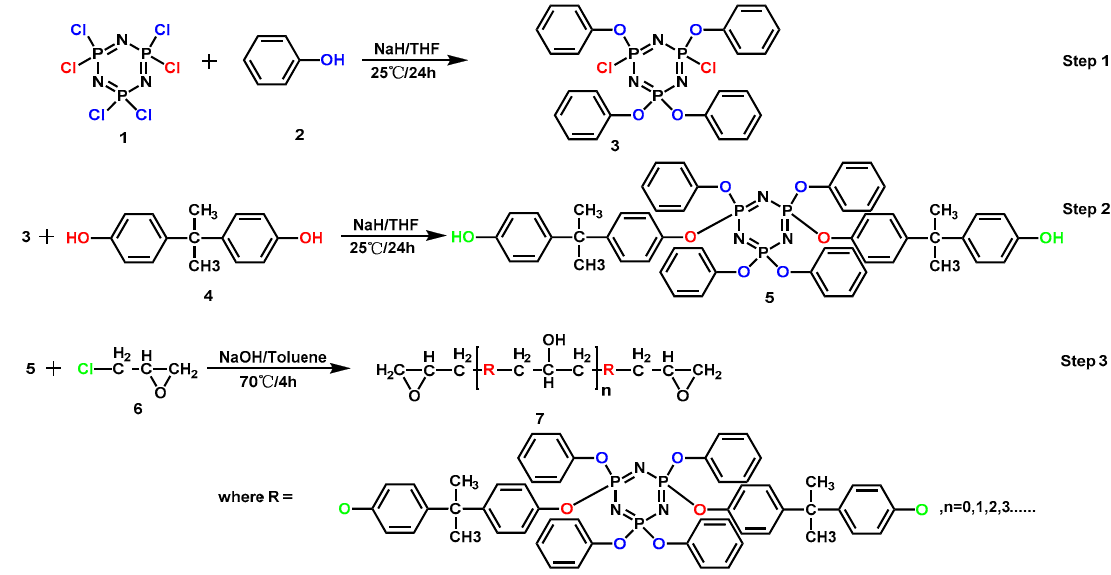
Figure 11. Synthesis route of cyclolinear cyclotriphosphazene-linked EP. Readapted with permission from Ref. [100], Copyright 2012, American Chemical Society.